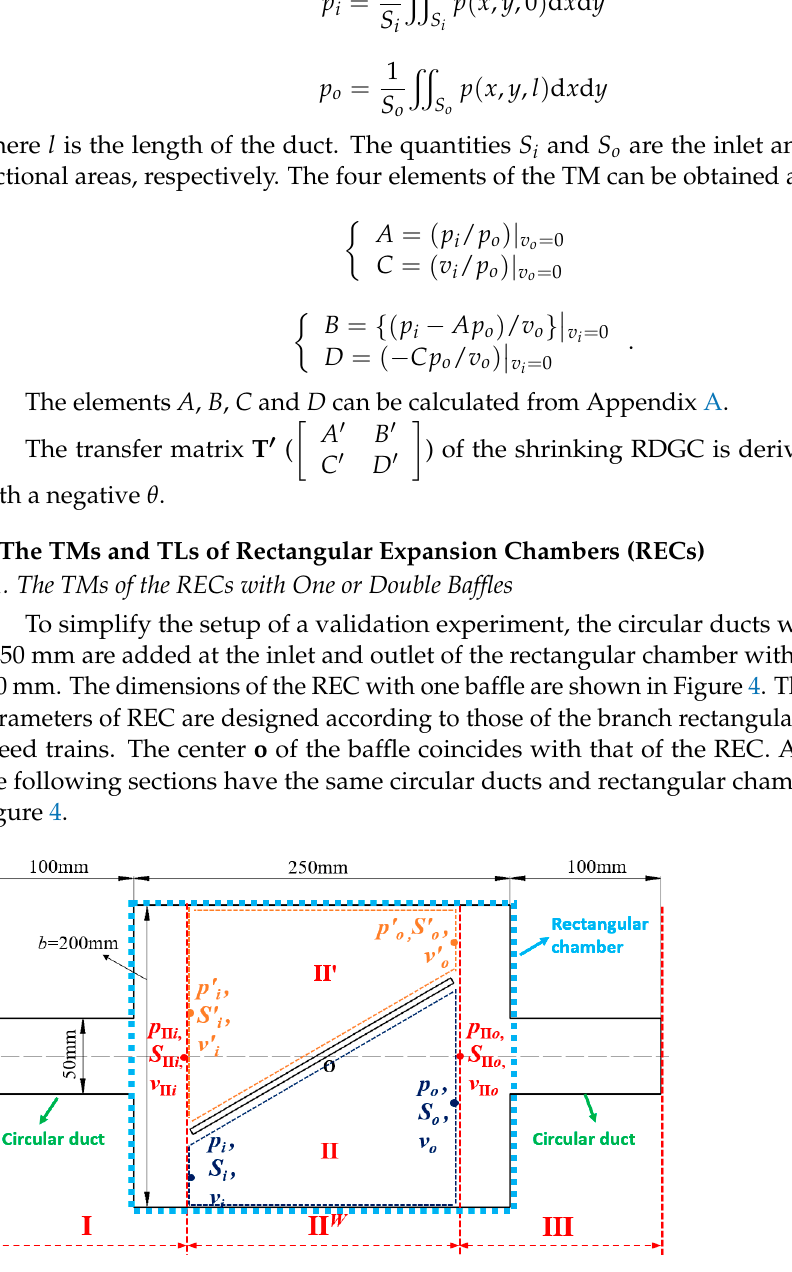
Figure 4. The gemometry of the REC with one baffle.